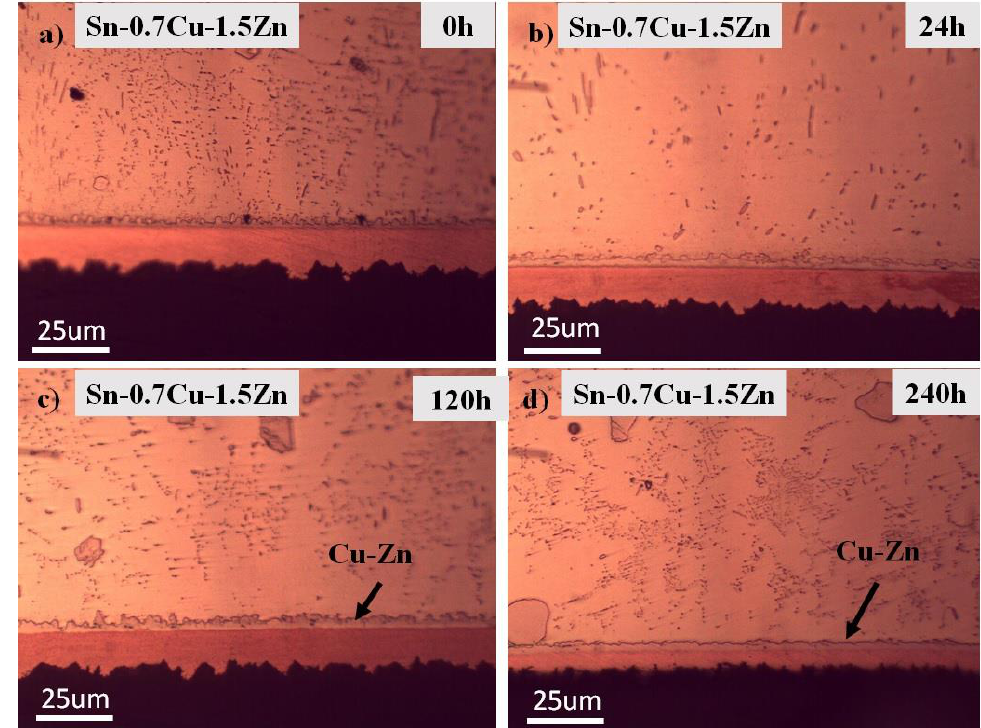
Figure 10. Microstructure of Interfacial IMC of Sn-0.7Cu-0.5Zn after annealing at ( a ) 0 h, ( b ) 24 h, ( c ) 120 h and ( d ) 240 h at 180 °C. ( c ) 120 h and ( d ) 240 h at 180 ◦